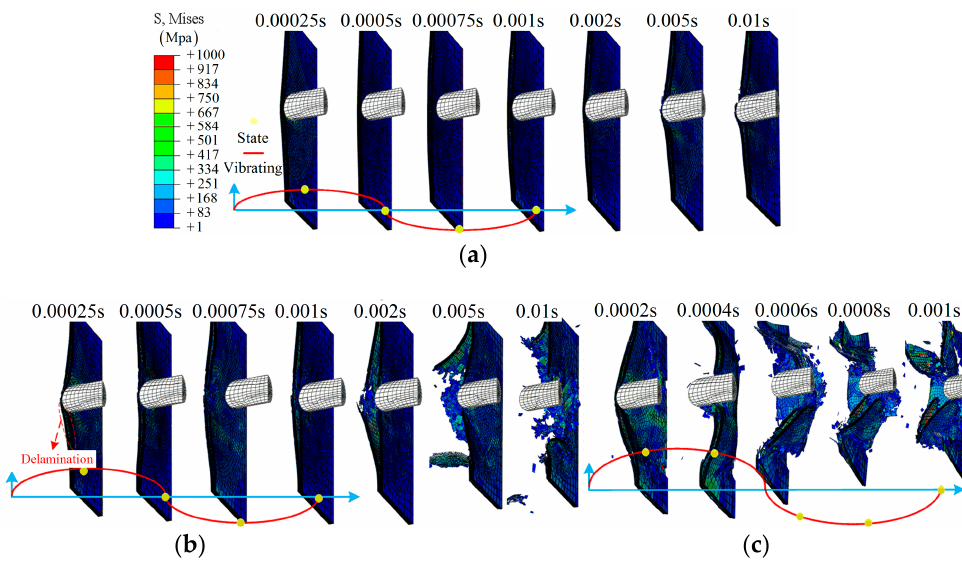
Figure 13. The middle section of the half model during the impact: ( a ) group C2; ( b ) group C3; ( c ) group C4.